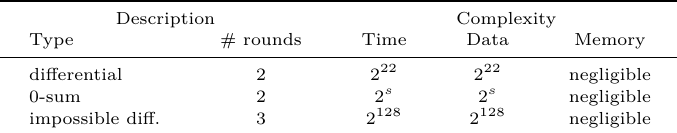
Table 2: Our best distinguishers against round-reduced MOE . Time is measured in number of encryptions, data is measured in number of plaintext/ciphertext pairs; s is any integer such that 2 ≤ s < n